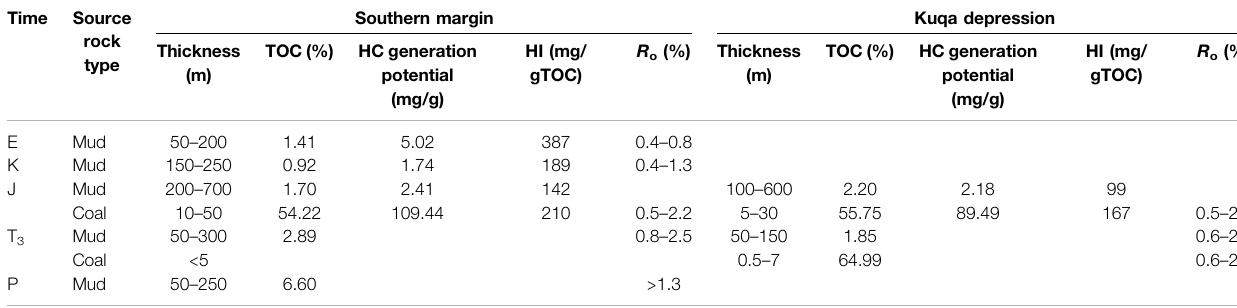
TABLE 1 | Comparison of source rocks between southern margin and Kuqa Depression a